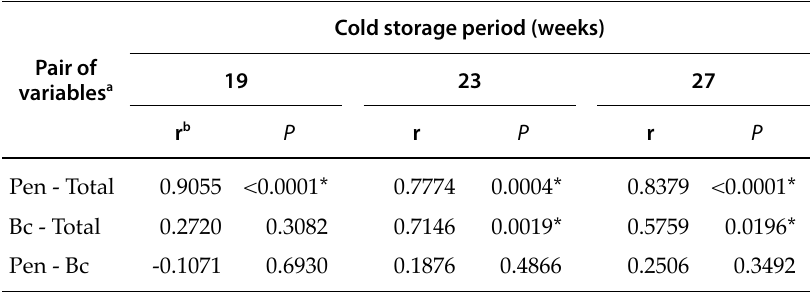
Table 2. Correlations among the incidence of postharvest diseases on commercially-handled pomegranates cv. Mollar de Elche stored at 5ºC and 90% RH for 19, 23, or 27